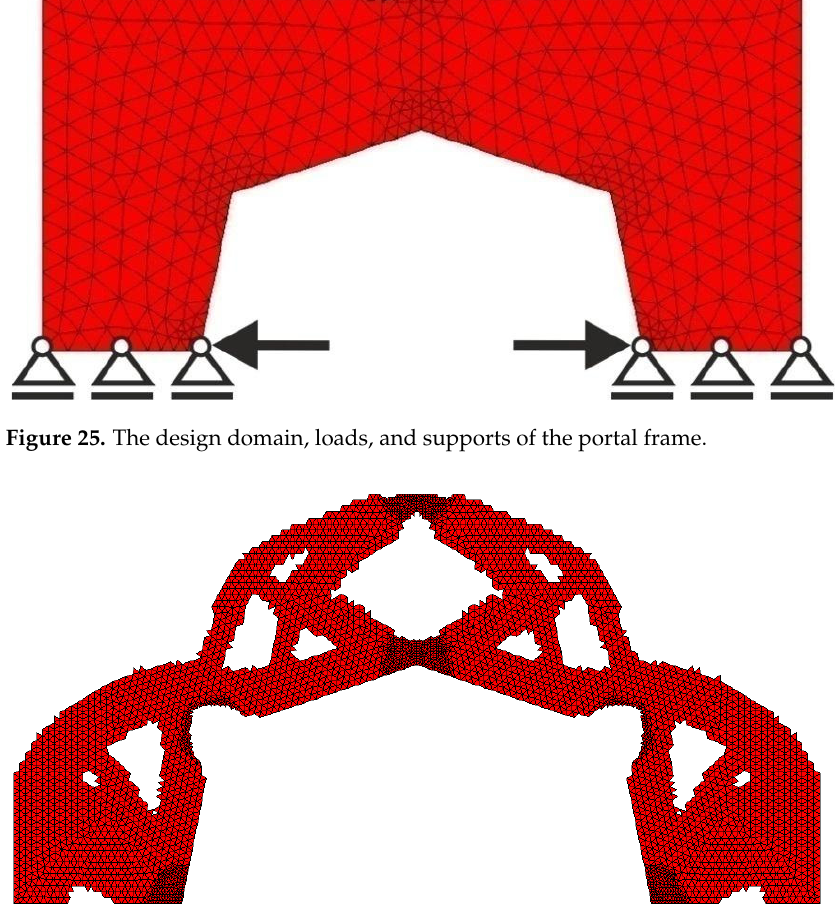
Figure 26. The final topology found for the portal frame.